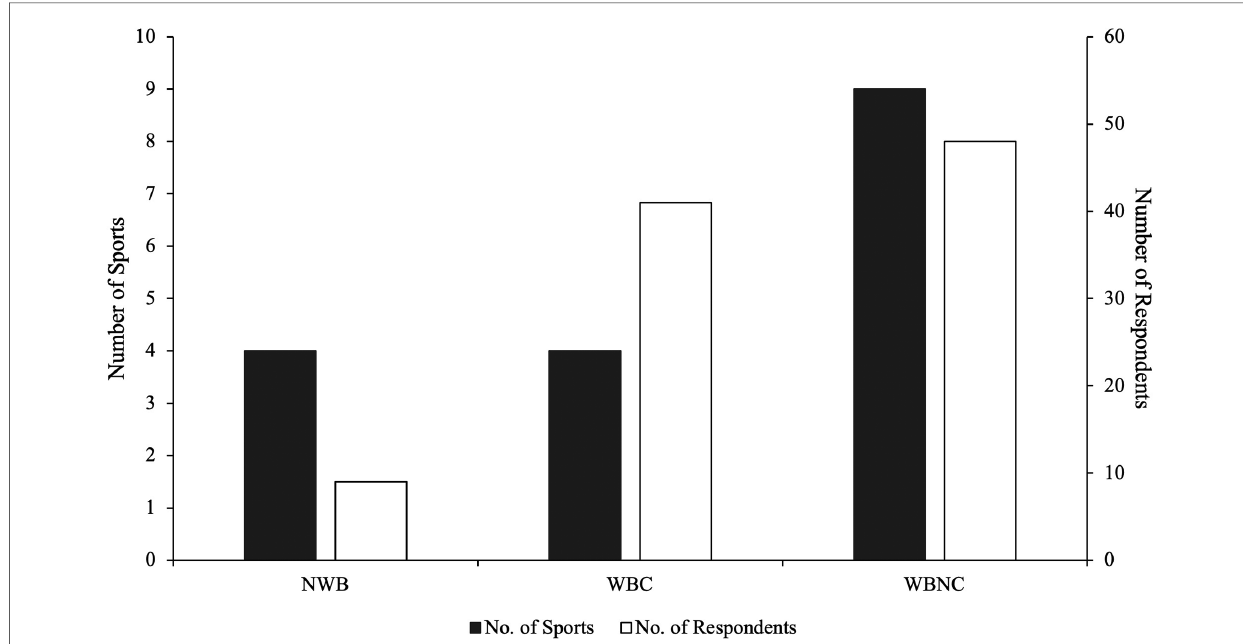
FIGURE 1 Number of survey respondents alongside number of sports classi fi ed into sporting conditions. Sporting conditions are classi fi ed as; non weight-bearing sports (NWB) include cycling, swimming, canoeing and rowing; weight-bearing contact sport (WBC) include Football/Soccer, Rugby, Judo and American football; weight-bearing non-contact sport (WBNC) include Cricket, Athletics, Basketball, Volleyball, Field Hockey, Baseball, Triathlon, Dance and